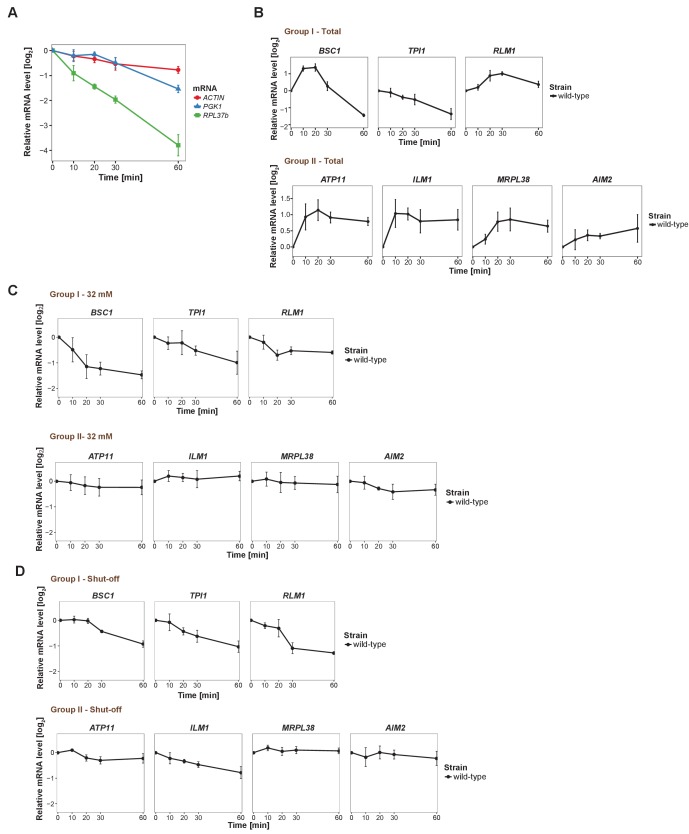
Changes in total candidate mRNA levels and validation of pulse-chase protocol.(A) Evaluation of qRT-PCR reference genes stability after glucose depletion. The total mRNA levels of three commonly used reference genes were measured by qRT-PCR and normalized to spike-in RNA control as described in Materials and methods. (B) Fold changes of total candidate mRNA levels after glucose depletion were determined by qRT-PCR using ACT1 as reference. (C) The stability of candidate mRNAs was determined by performing the pulse-chase experiment with 32 mM uracil, followed by qRT-PCR. (D) The stability of mRNAs was examined by qRT-PCR after blocking transcription by 1, 10-phenanthroline in the wild type strain at indicated time points following a shift to glucose-depleted media. Group I: non-mitochondria-related candidates. Group II: mitochondria-related candidates. Error bars, mean ±SEM.10.7554/eLife.29815.014Figure 3—Figure Supplement 1—source data 1.Data used for plotting.Files contains data for panel A of Figure 3—figure supplement 1.
10.7554/eLife.29815.015Figure 3—Figure Supplement 1—source data 2.Data used for plotting.Files contains data for panel B of Figure 3—figure supplement 1.
10.7554/eLife.29815.016Figure 3—Figure Supplement 1—source data 3.Data used for plotting.Files contains data for panel C of Figure 3—figure supplement 1.
10.7554/eLife.29815.017Figure 3—Figure Supplement 1—source data 4.Data used for plotting.Files contains data for panel D of Figure 3—figure supplement 1.